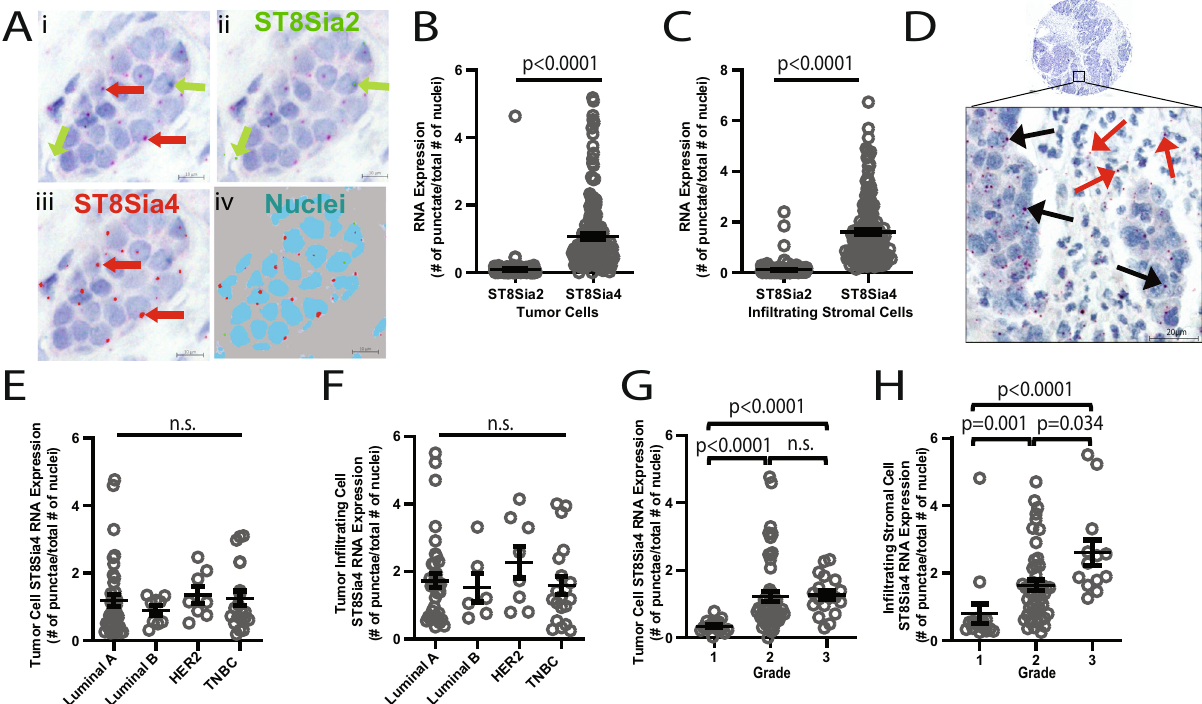
Fig. 2 ST8Sia2 and ST8Sia4 expression in primary breast tumors. A ST8Sia4 and ST8Sia2 in situ hybridization (ISH) and identi fi cation of ST8Sia2 (ii), ST8Sia4 (iii), and nuclei (iv) using Intellesis software. Red arrows point to (i) ST8Sia4 RNA punctae from ISH staining and (iii) ST8Sia4 RNA punctae as identi fi ed by Intellesis software. Green arrows point to (i) ST8Sia2 RNA punctae from ISH staining and (ii) ST8Sia2 RNA punctae as identi fi ed by Intellesis software. Scale bar = 10 µm. B and C Quanti fi cation of the total number of ST8Sia2 and ST8Sia4 RNA punctae as a ratio of total number of tumor cell nuclei ( B ) or in fi ltrating stromal cell nuclei ( C ). ±SEM, unpaired t test with Welch ’ s correction. D Representative image of a ST8Sia4 high expressing tumor. Black arrows point to ST8Sia4 RNA punctae in tumor cells and red arrows point to ST8Sia4 RNA punctae in in fi ltrating stromal cells. Scale bar = 20 µm. E and F ST8Sia4 expression in ( E ) tumor cells (luminal A, n = 39; Luminal B, n = 9; HER2 + , n = 8; TNBC, n = 20) and F in fi ltrating stromal cells (Luminal A, n = 37; Luminal B, n = 6; HER2 + , n = 8; TNBC, n = 20) grouped by molecular subtype. G and H ST8Sia4 expression in G tumor cells (Grade 1, n = 17; Grade 2, n = 51, Grade 3, n = 18) and H in fi ltrating stromal cells (Grade 1, n = 16; Grade 2, n = 48, Grade 3, n = 13) grouped by overall tumor grade. ±SEM, Kruskal – Wallis